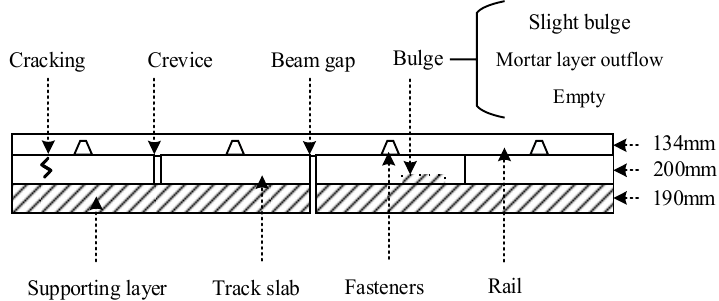
Figure 1. Typical defects in track detection.